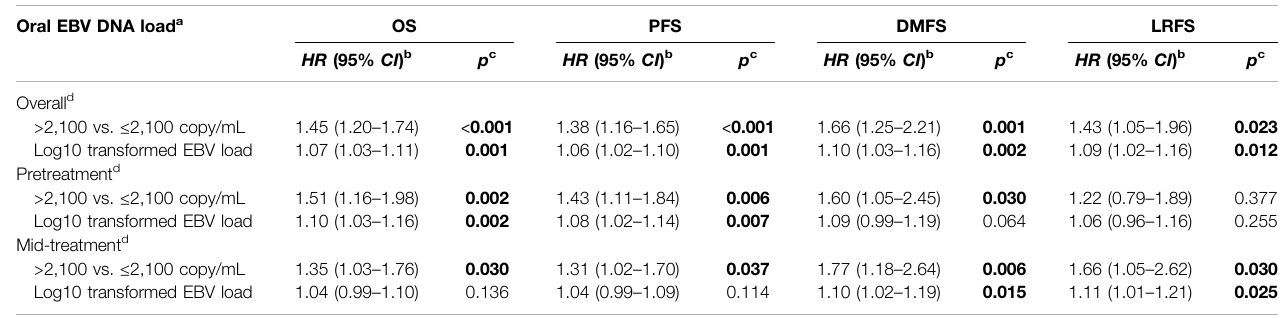
TABLE 3 | Multivariate Cox regression analysis of the oral EBV DNA load with NPC survivals. Oral EBV DNA load